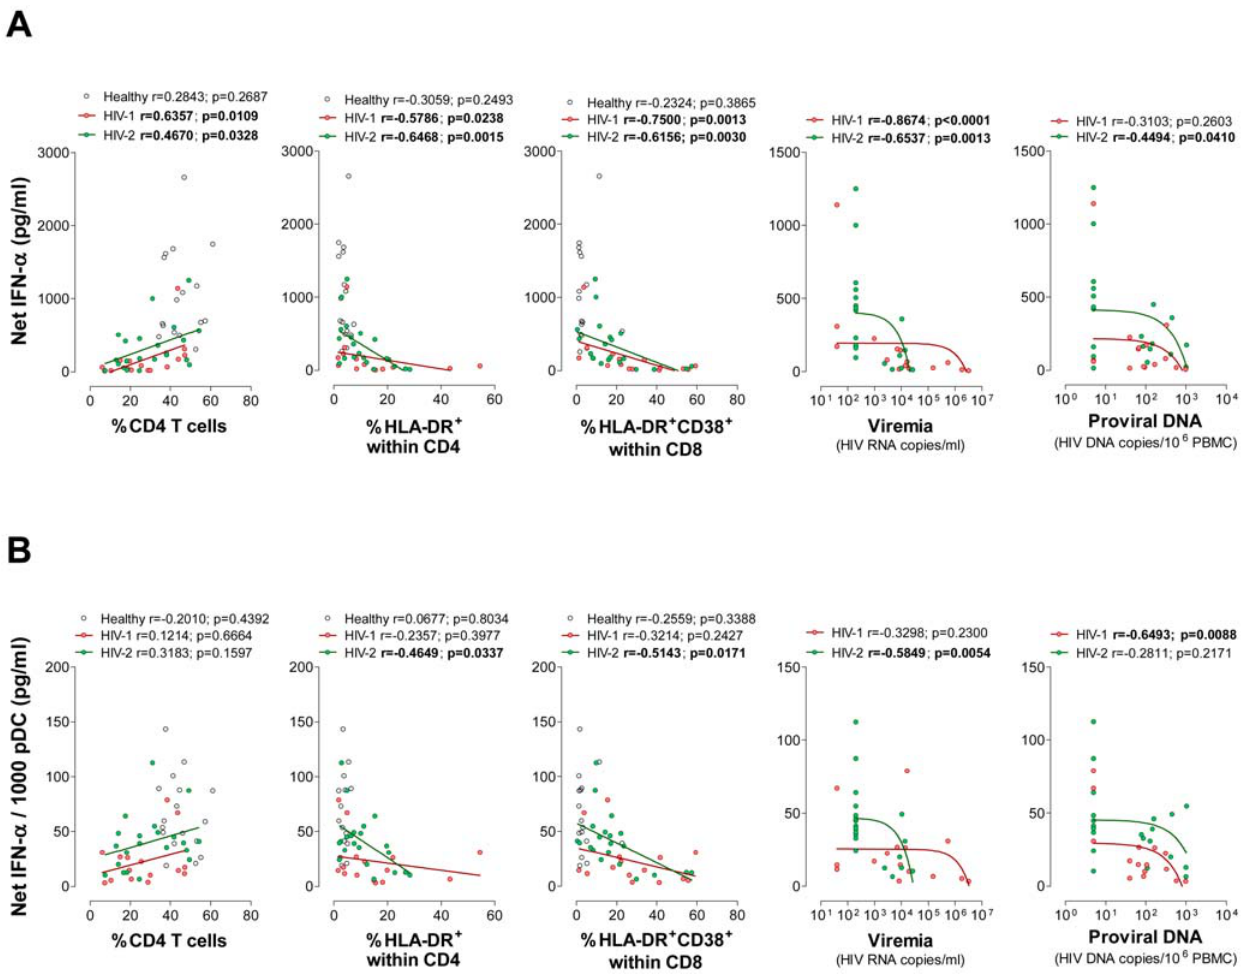
Figure 5. Relationship of IFN- a production upon CpG stimulation with CD4 T cells, T cell activation, viremia and proviral DNA levels. Correlations of frequency of circulating CD4 T cells, proportion of CD4 T cells that express HLA-DR, proportion of CD8 T cells that simultaneously express HLA-DR and CD38, viremia and levels of proviral DNA with the Net IFN- a production ( A ) and the Net IFN- a per 1000 pDC ( B ) upon in vitro CpG stimulation. Each dot represents one individual from the HIV-2 cohort, the HIV-1 cohort and healthy